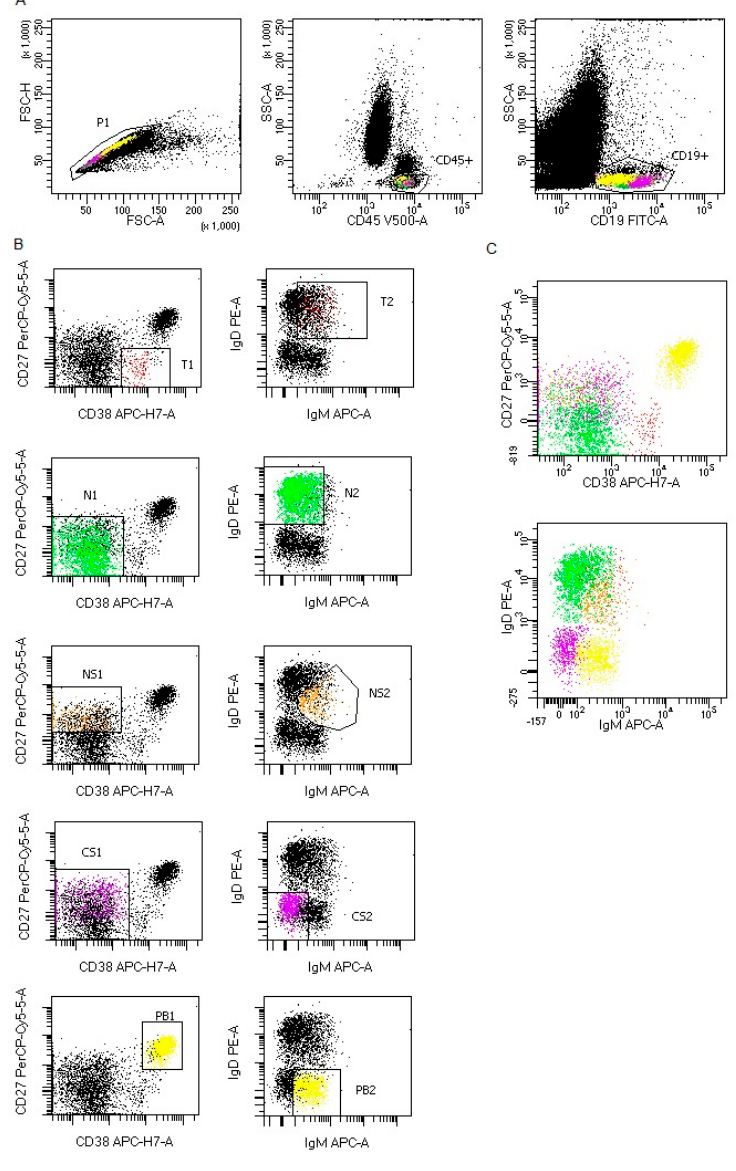
Figure 1. Representative B lymphocytes maturation gating strategy in COVID-19 patients. ( A ) B lymphocytes gating strategy: FSC-A vs. FSC-H plot: Gating the cells that have an equal area and height, thus removing clumps (greater FSC-A relative to FSC-H) and debris (very low FSC), CD45 vs. SSC-A plot: Broad selection of lymphocytes based on their SSC / CD45 properties, CD19 vs. SSC-A plot: Broad selection of lymphocytes B based on their SSC / CD19 properties. ( B ) B lymphocytes maturation gating strategy for each maturation subsets: T1,T2-transitional B cells, N1,N2-naïve B cells, NS1, NS2-non-switched memory B cells, CS1, CS2-class switched memory B cells and PB1, PB2-plasmablasts. ( C ) representative plots with all B lymphocytes maturation subsets. CD27 vs. CD38 plot: Broad selection of B lymphocyte maturation subsets based on their CD27 / CD38 properties, IgD vs. IgM plot: Broad selection of B lymphocyte maturation subsets based on their IgD / IgM properties. Plots show all B lymphocyte maturation subsets: Transitional B cells (red), naïve B cells (green), non-switched memory B cells (orange), class switched memory B cells (purple) and plasmablasts (yellow).